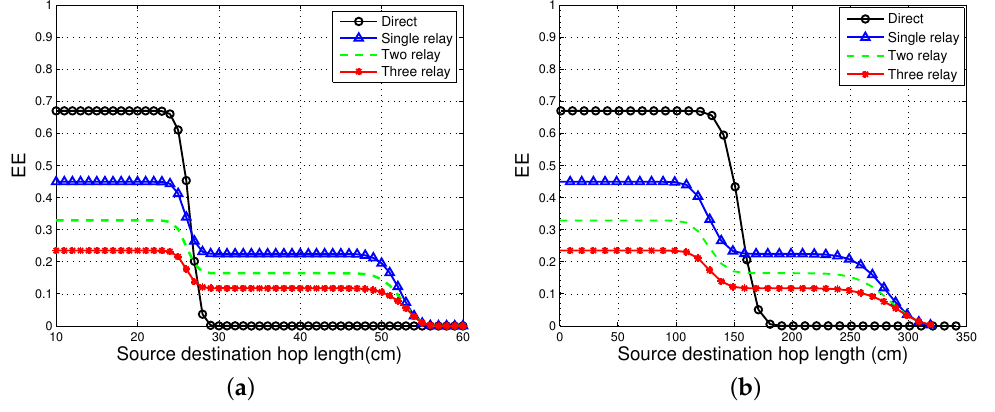
Figure 3. Energy efficiency (EE) analysis. ( a ) EE for on-body NLOS communication; ( b ) EE for on-body LOS